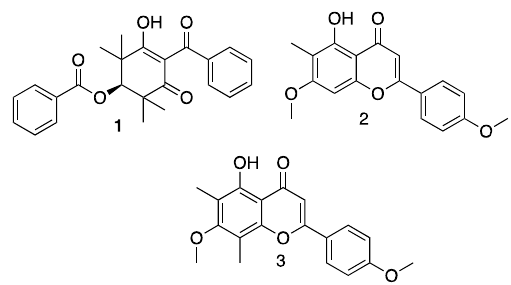
Figure 2. Structures of tristaenone A ( 1 ), 8-desmethyleucalyptin ( 2 ) and eucalyptin ( 3 ).